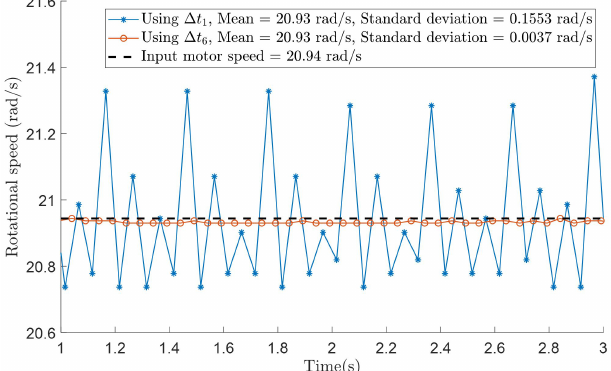
Figure 4. An example of the processed rotational speed with ∆ t 1 and ∆ t 6